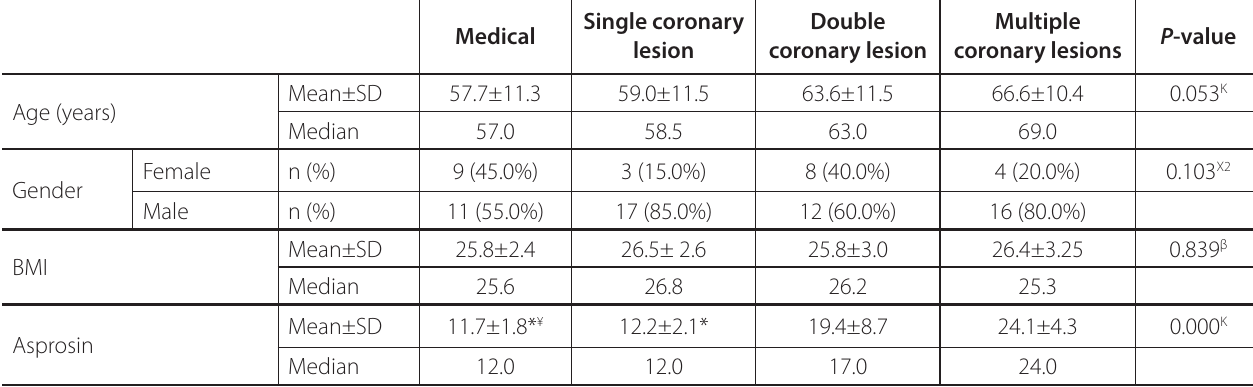
Table 2 . Demographic data and Asprosin distributions by groups.